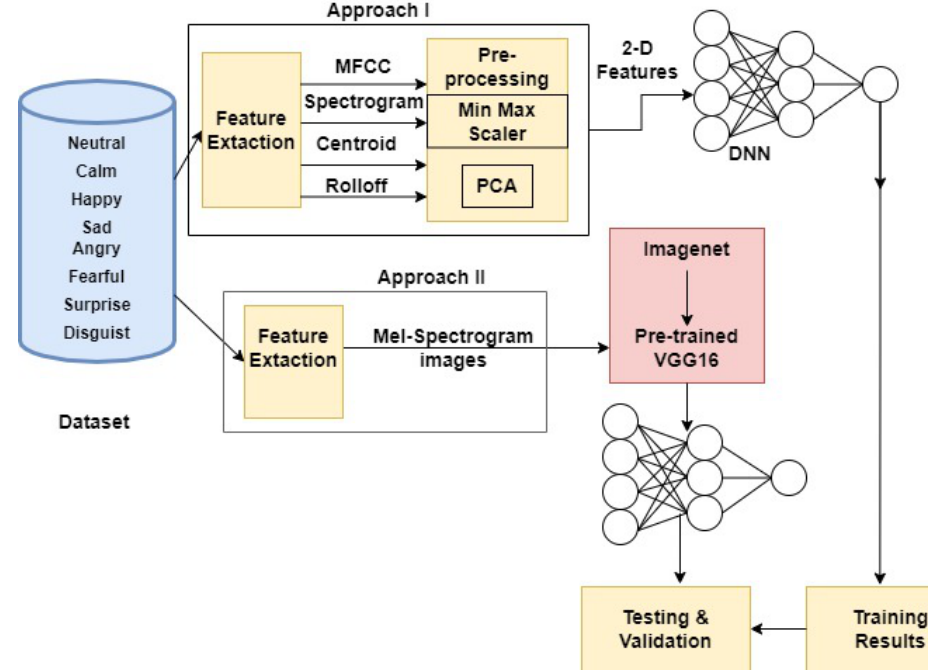
Figure 1. Schematic representation of two-way feature extraction for speech